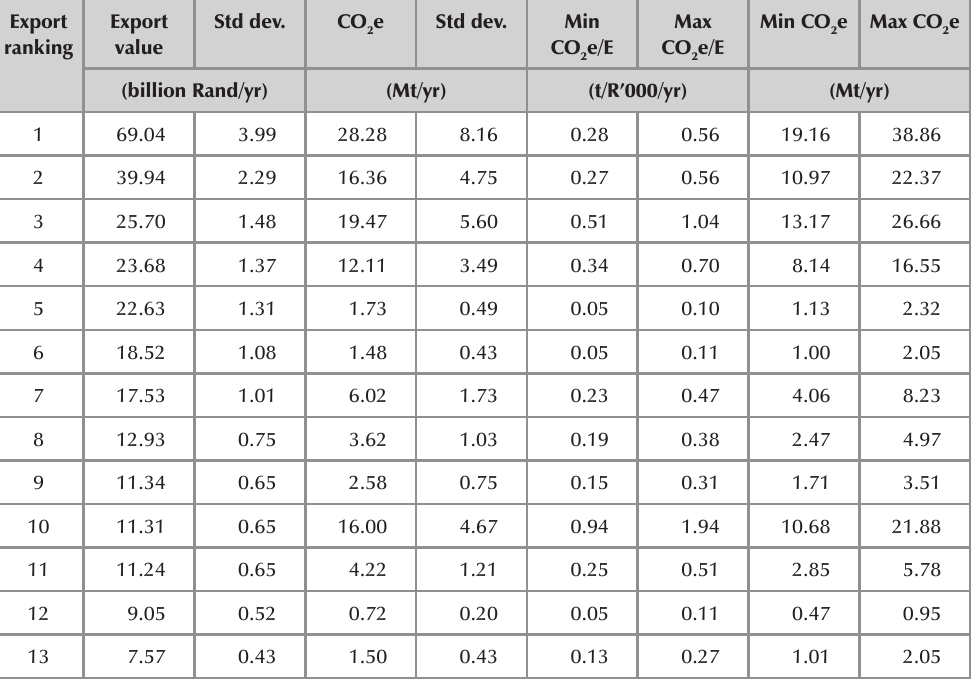
e emissions for the top 20 exports 2